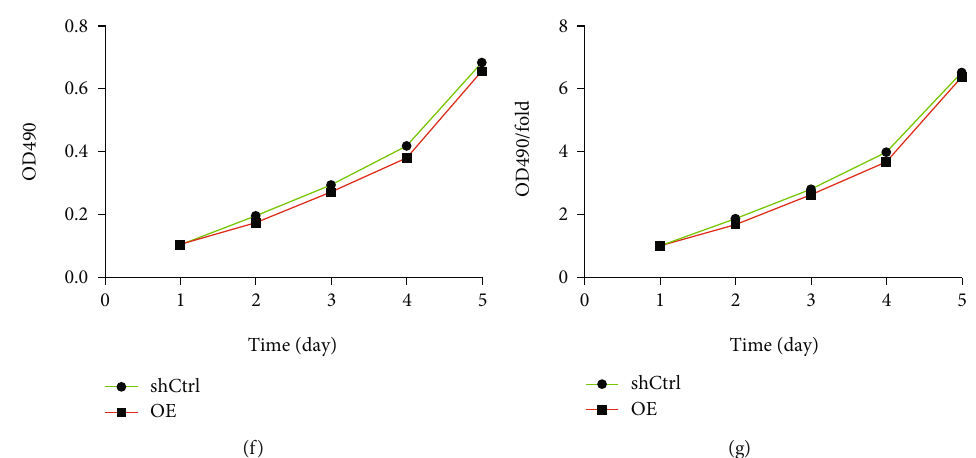
Figure 6: Sequencing of SCARA5 gene exons in the ESCC cells. (a) 11 exon mutations were found in the three ESCC cell lines, and four of the 11 mutations were identical across all the three cell lines. (b – g) In the Eca109, EC9706, and TE-1 cell lines, no signi fi cant changes were observed in cell proliferation in the WT OE group compared with the control group. Table 6: Comparison of exon sequence and wild-type sequence of 3 esophageal squamous cell carcinoma cell lines of SCARA5.